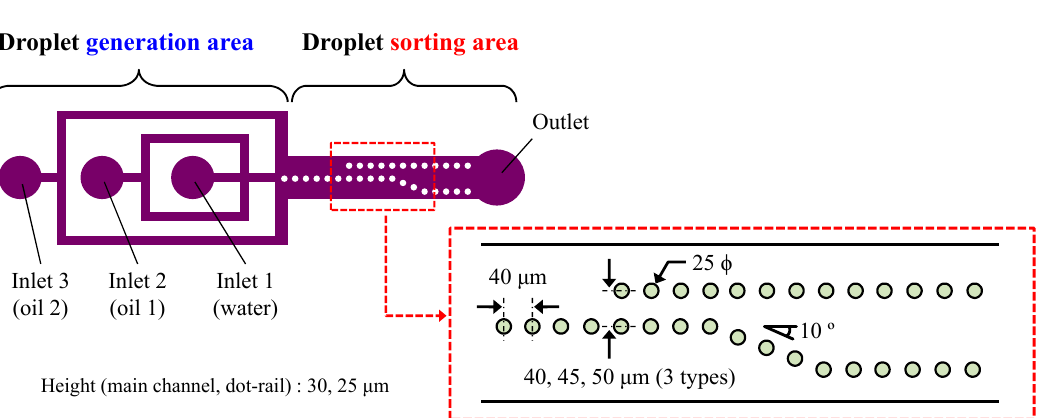
Figure 3. Schematic view of the total device and detailed dimensions of the channel structure.